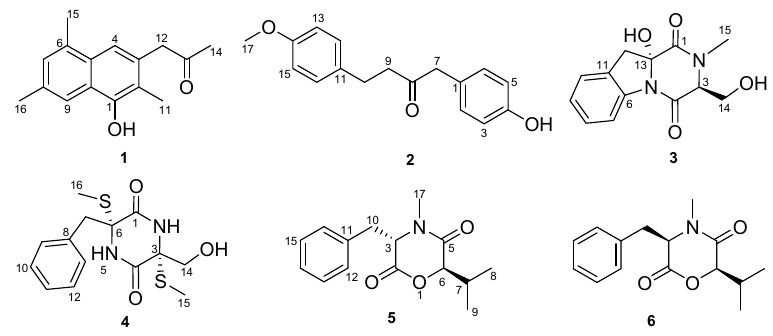
Figure 1. Chemical structures of compounds 1 – 6 .